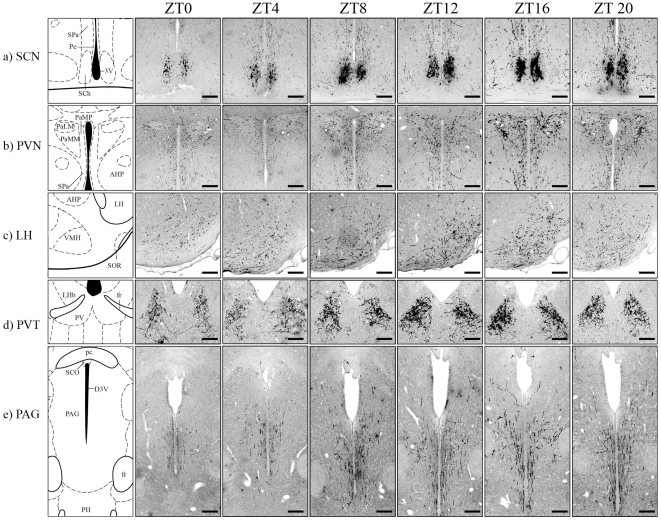
Circadian variation in the intensity of EGFP-ir fibers in many SCN target sites correlated with the expression of EGFP in the SCN.Side-by-side comparisons of coronal sections through the suprachiasmatic nucleus (SCN), paraventricular nucleus (PVN), lateral hypothalamic area (LH), paraventricular thalamic nucleus (PVT) and periaqueductal gray (PAG) during 24 hours showed that the number of EGFP-positive cells in the SCN reached its nadir at ZT0 and peaked around ZT12. Meanwhile, the intensities of EGFP-ir fibers in many SCN target areas also ebbed and flowed following the same chronological pattern. Scale bar  =  100 µm.